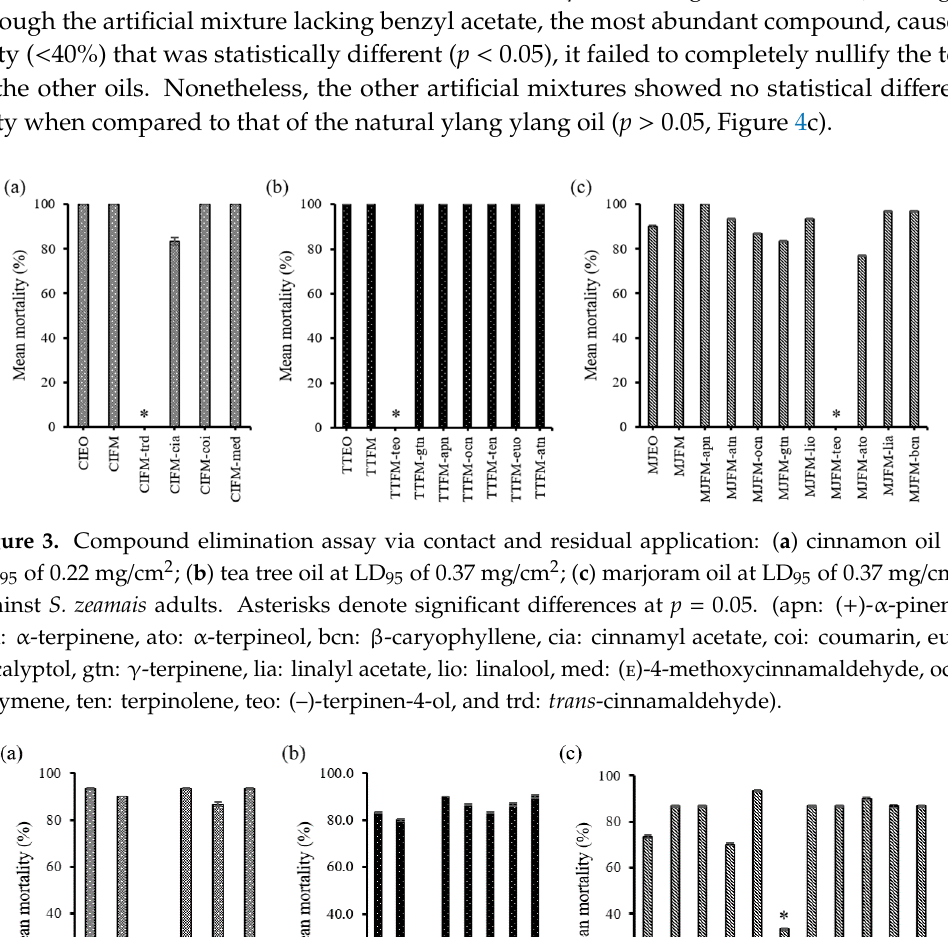
9 of 15 3.4. Comparative Toxicity of the Major Constituents In the compound elimination assay using marjoram and tea tree oils via the contact and residual application method, the artificial mixtures failed to cause any mortality to the adult weevils when terpinen-4-ol was excluded from the full mixtures (Figure 3a,b). On the other hand, the mortality of all the remaining combinations containing terpinen-4-ol including the full mixture showed no